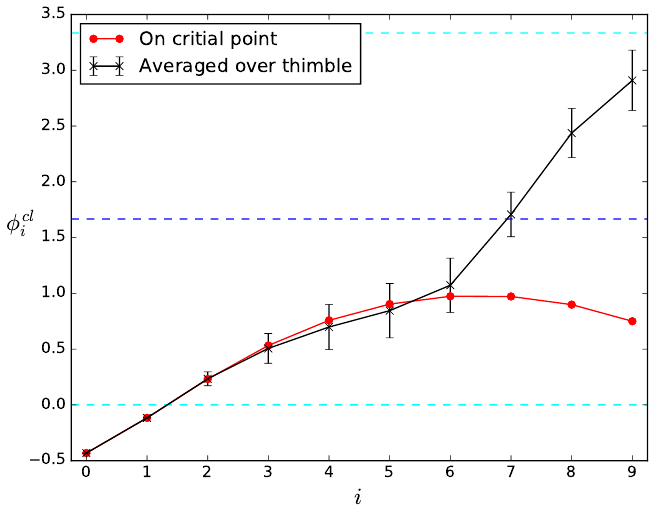
Figure 6 . (cid:30) cl restricted to a single thimble (single initialization) with g = 0 : 3. The red dots refer i to the values of (cid:30) cl on the critical point. So the red line represents the classical trajectory, which i is in this case oscillating only around one of the two minima, whose values are denoted in the plot by the dashed cyan lines, while the maximum of the potential by the dashed blue line. The black error bar indicates the mean and one standard error of Re[ h (cid:30) cl i ] evaluated over the whole i